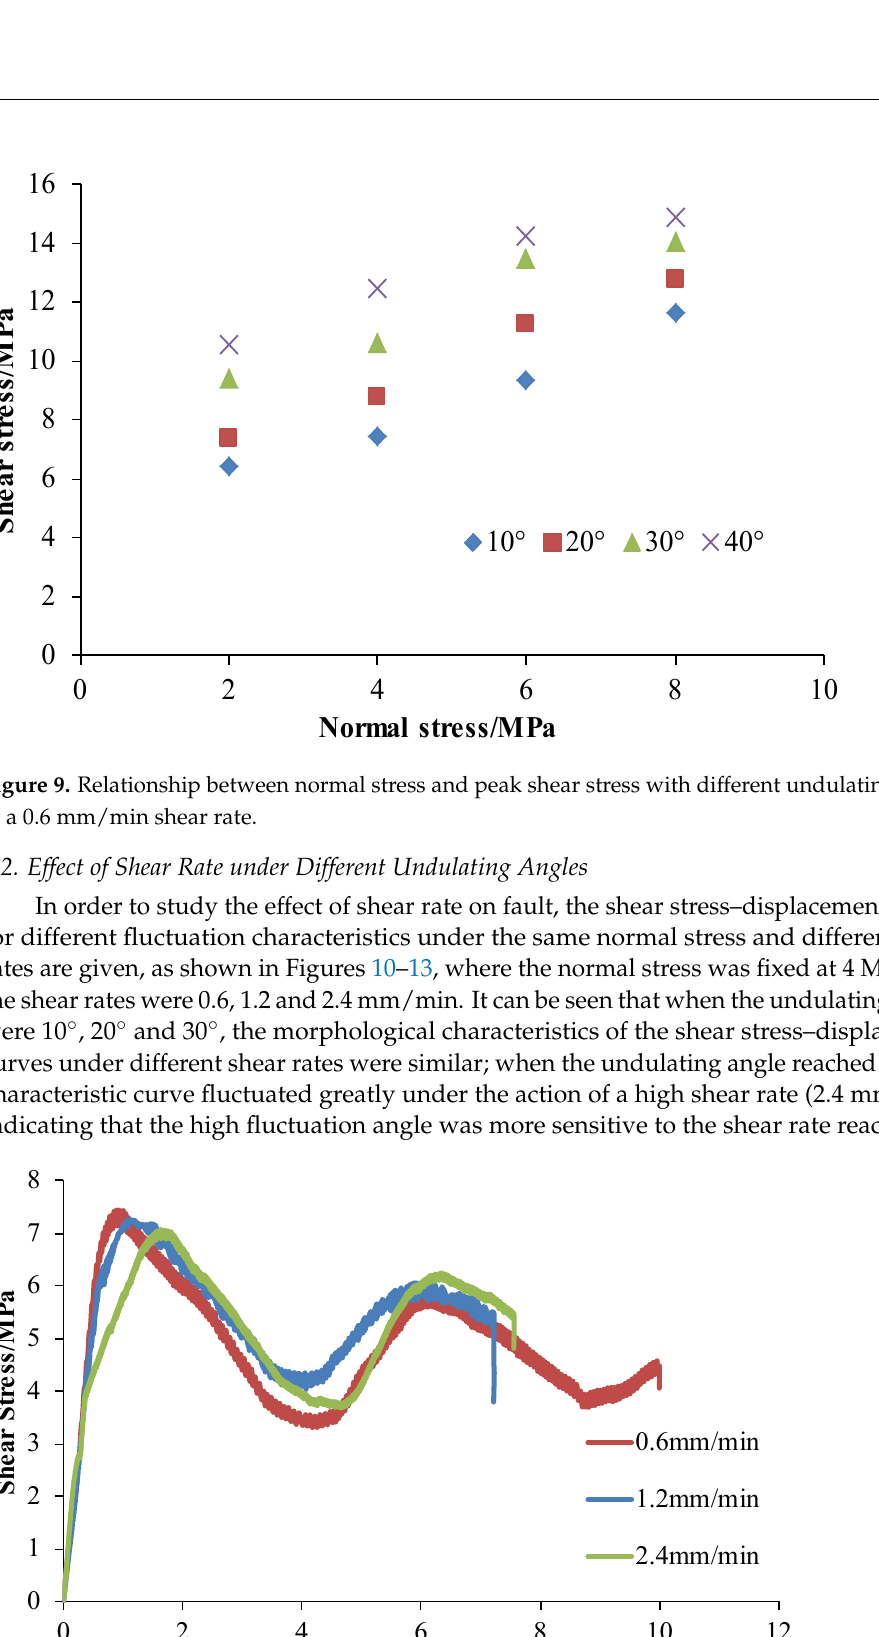
9 of 17 Figure 8. Shear stress–displacement curves under different normal stresses at a 0.6 mm/min shear rate with a 40° undulating angle. Table 2. Shear strength of structural planes with different undulating angles under different normal stresses at a 0.6 mm/min shear rate (MPa). Undulating Angle (°)